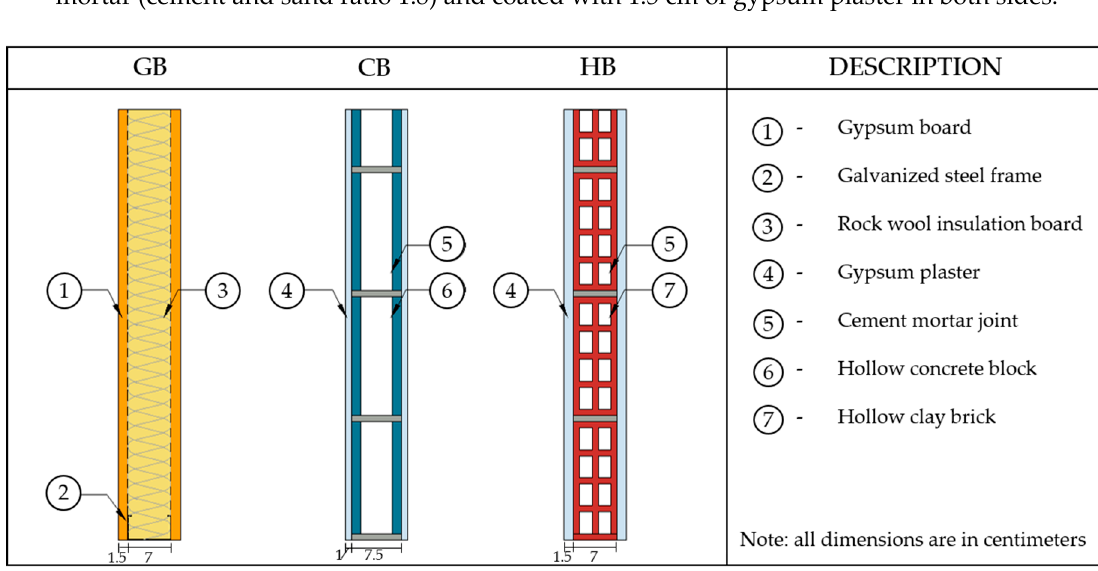
Figure 1. Constructive details and description of